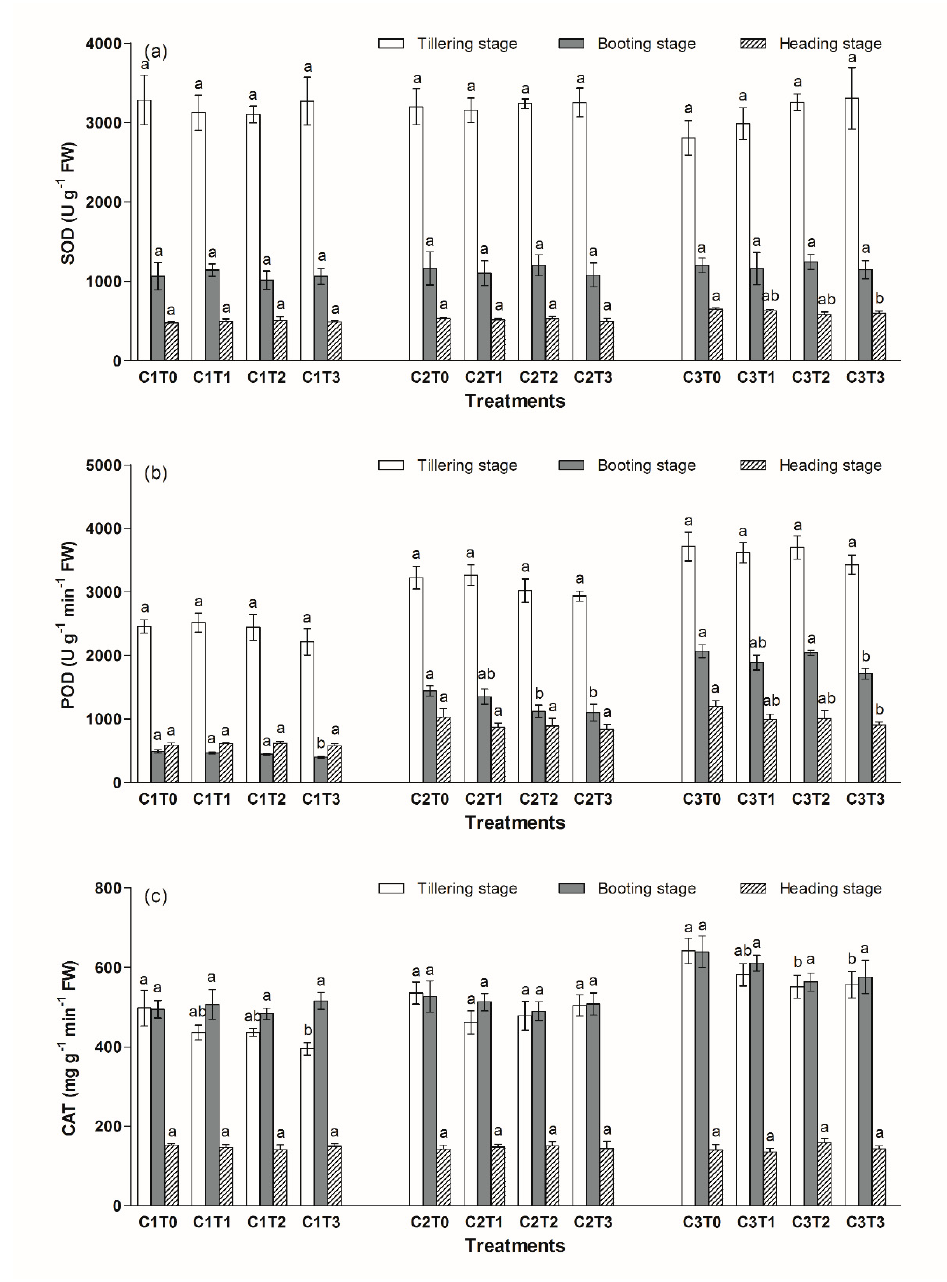
Figure 4. Changes in the superoxide dismutase (SOD) ( a ), peroxidase (POD) ( b ) and catalase (CAT) ( c ) activities in the leaves of Oryza saliva L. Different letters above columns indicate significant differences ( p < 0.05) between various treatment in same growth stage.